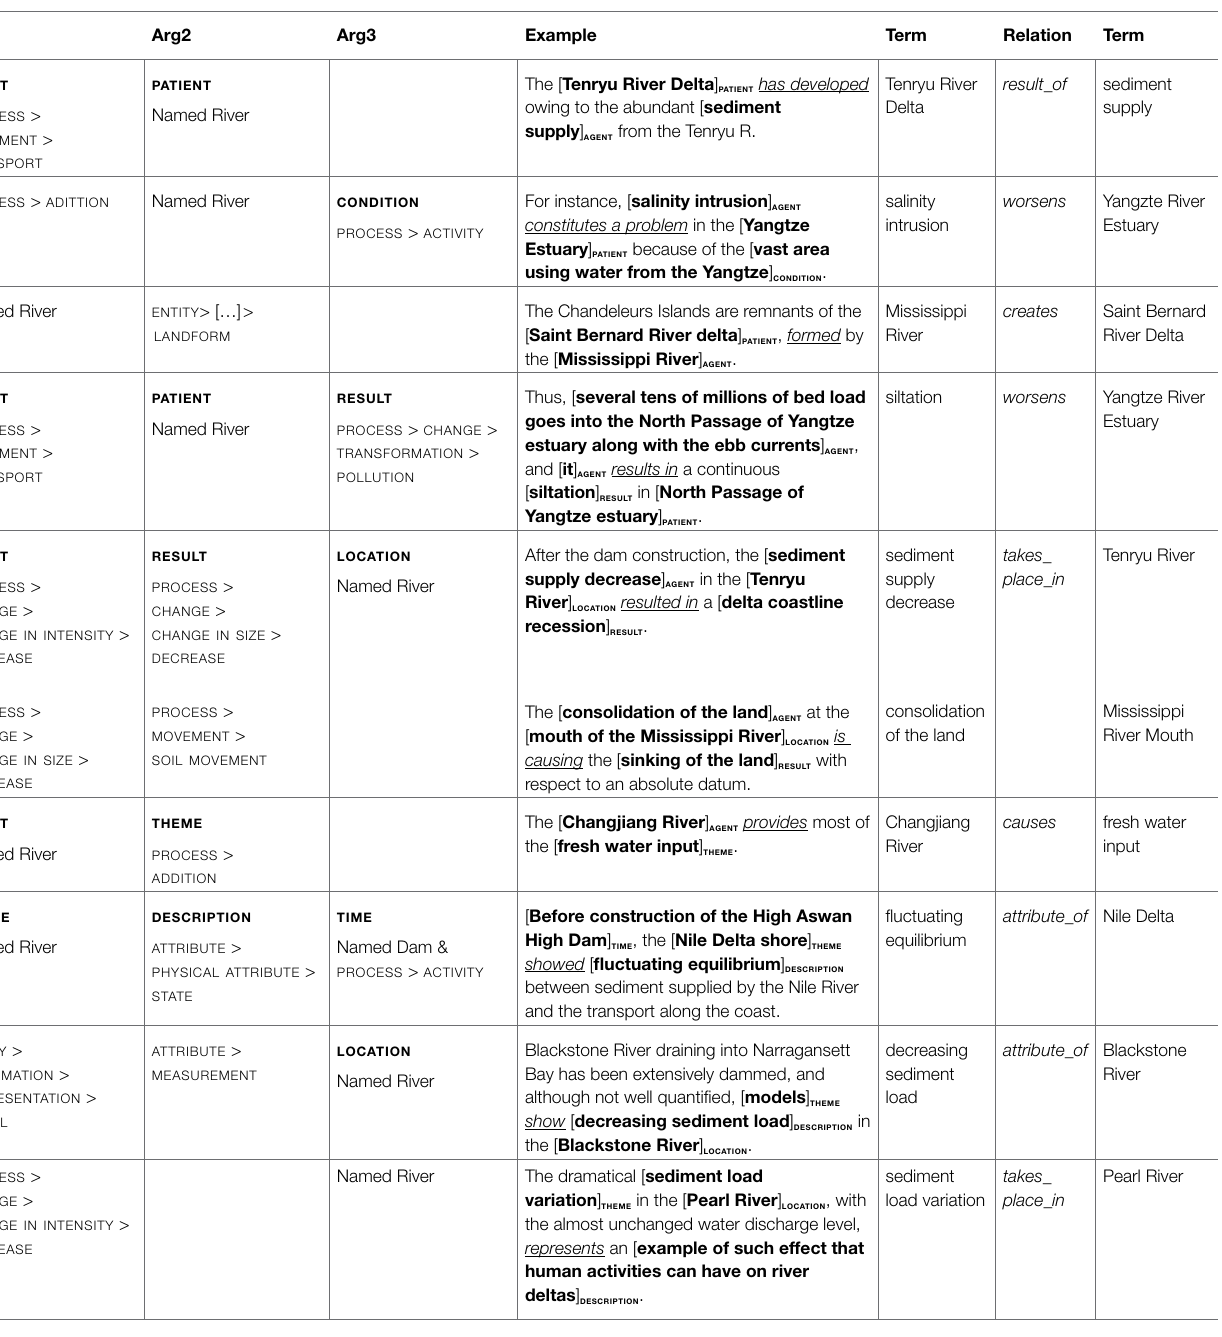
TABLE 7 | Results from the semantic annotations for the lexical domain of existence . Verb lexical domain: